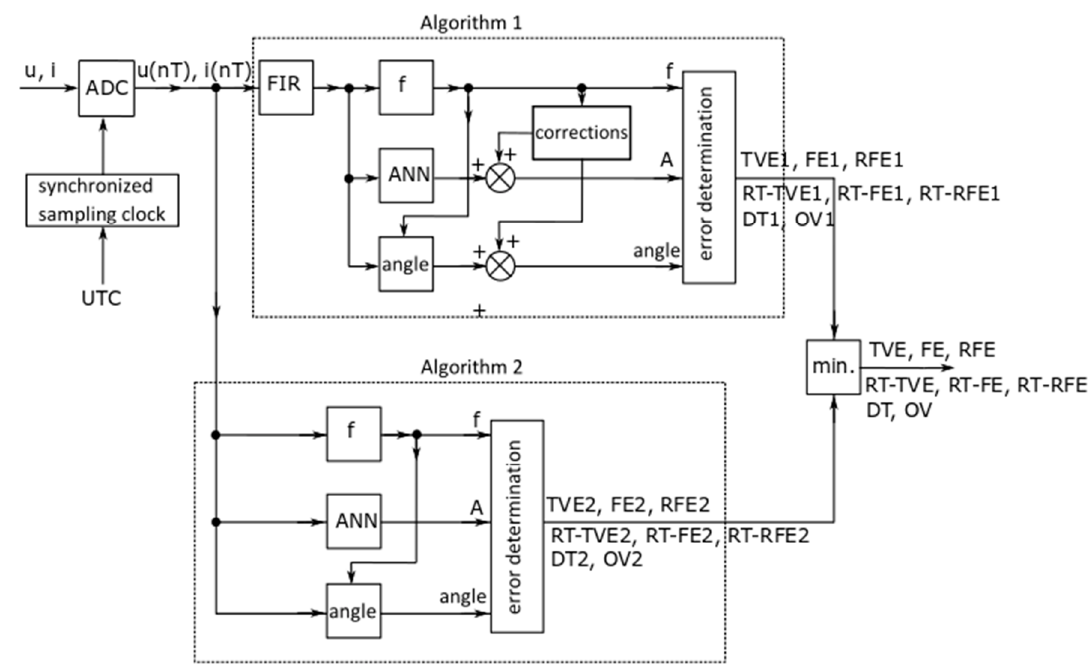
Figure 1. The flowchart of the algorithm for converting instantaneous voltage or current values into the synchrophasor parameters.